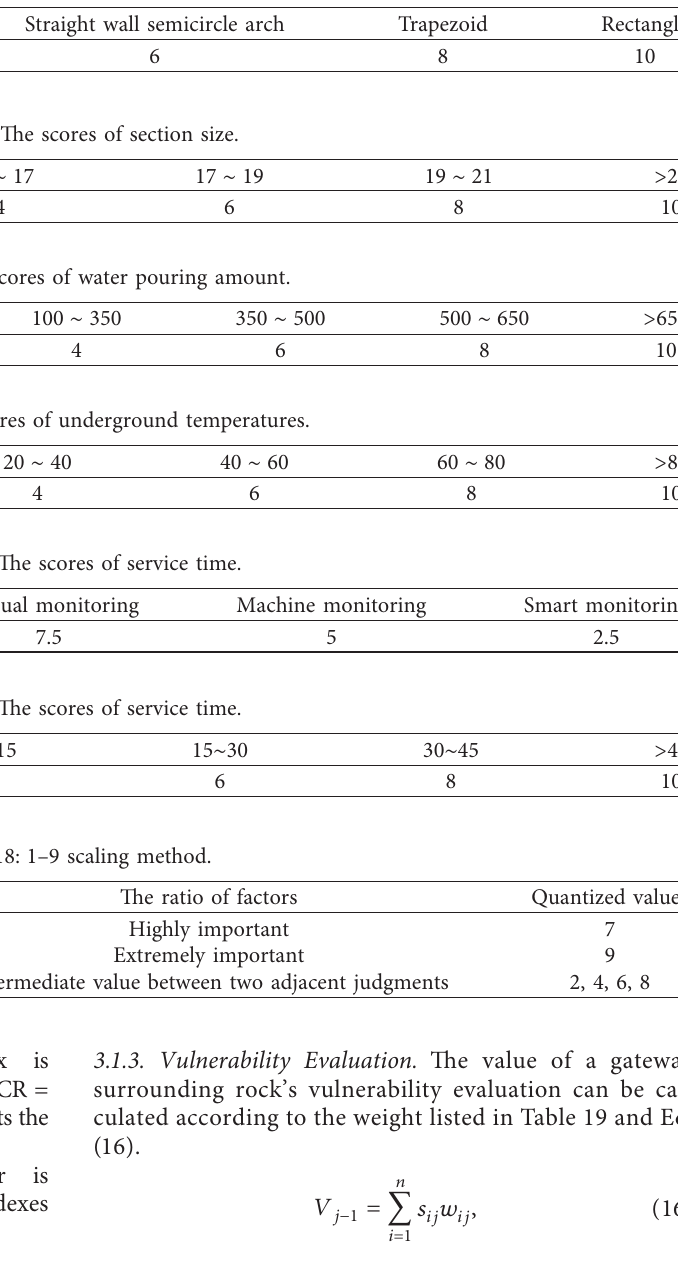
Table 12: The scores of section type.